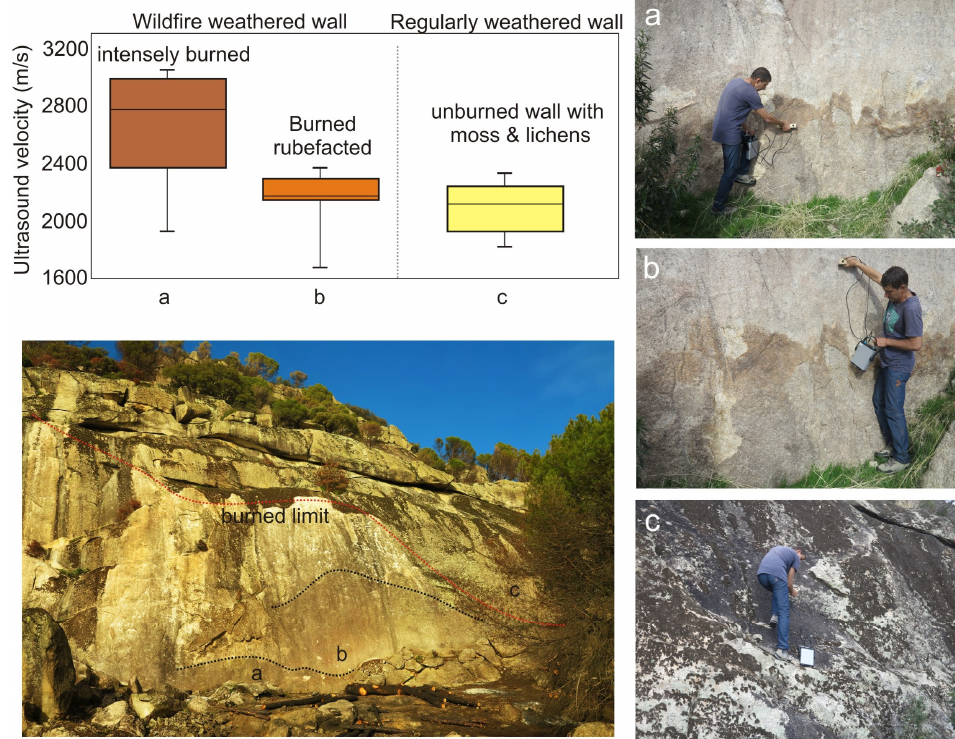
Figure 11. Detailed UPV values in the Cadalso de los Vidrios climbing wall along two areas with different degrees of fire damage: ( a , b ) wildfire weathering. ( a ) Intensely burned area with a soot deposit and detached spalling at the bottom part of the wall; ( b ) reddened area, which occurs above one meter in height; ( c ) area on the right side of the wall with preserved lichens and moss, indicating that it was not affected by the fire.